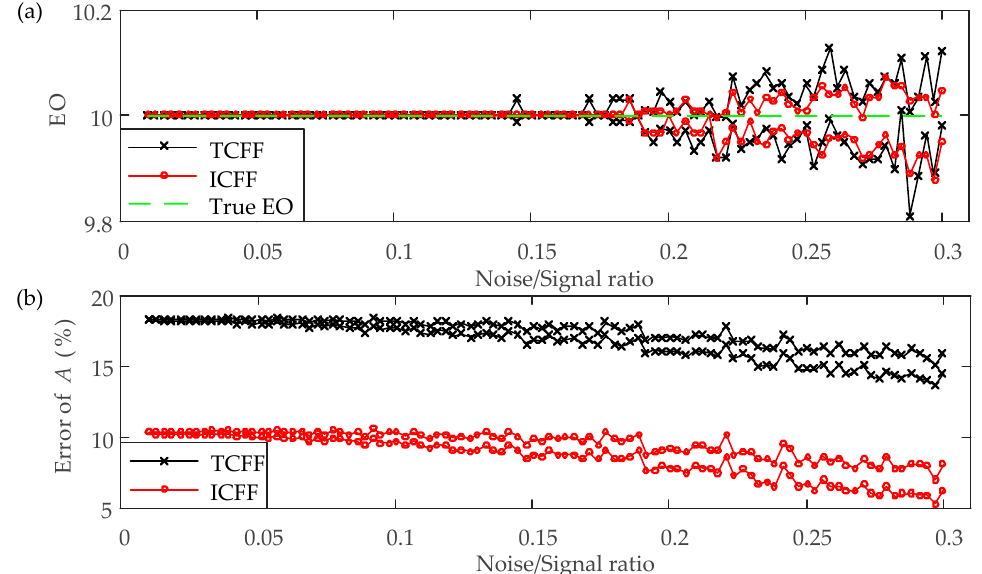
Figure 10. Results of Test 6. ( a ) 95% confidence intervals of the EO identification and ( b ) 95% confidence intervals of the relative error of the amplitude identification.